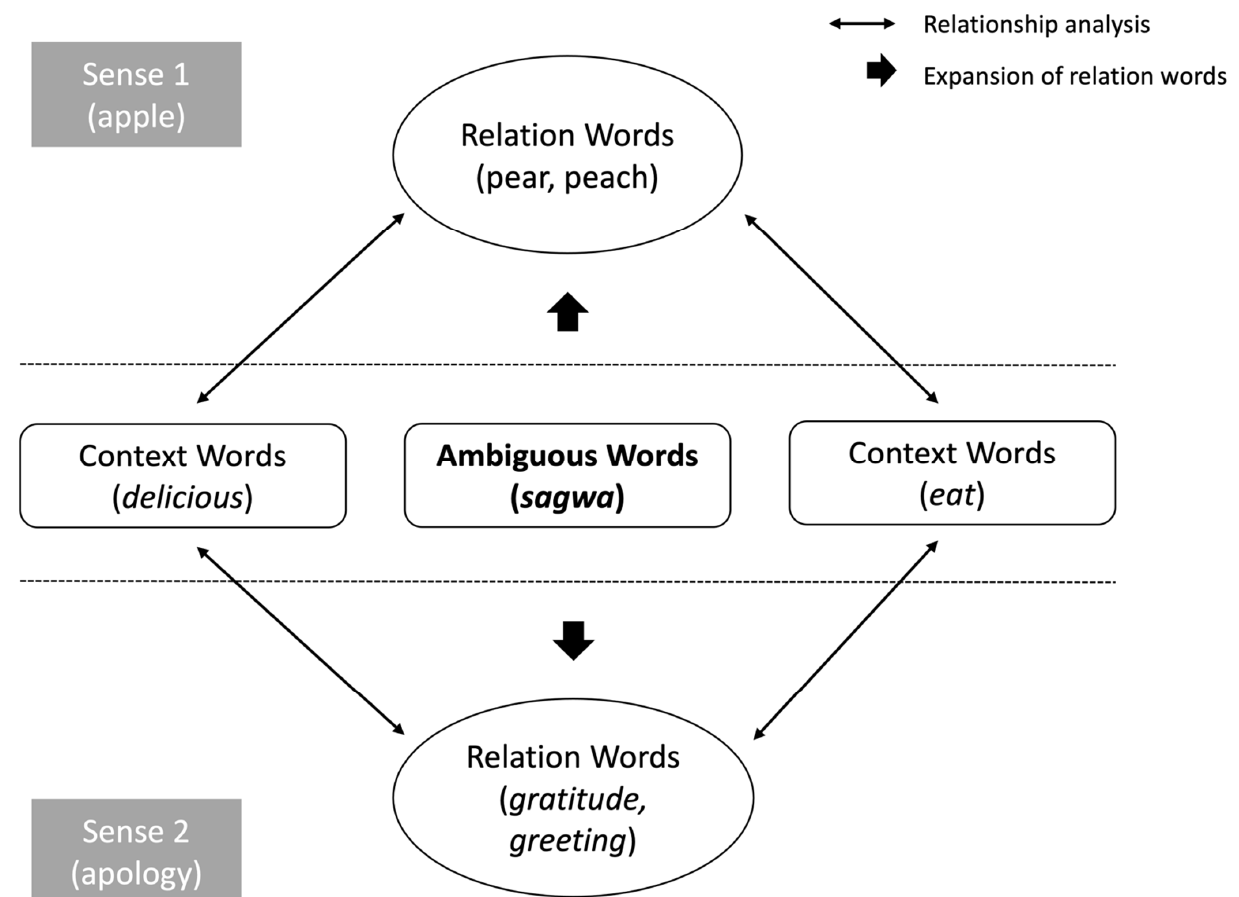
Figure 3. Relationship analysis between two words using the semantic relation words of an ambiguous word.